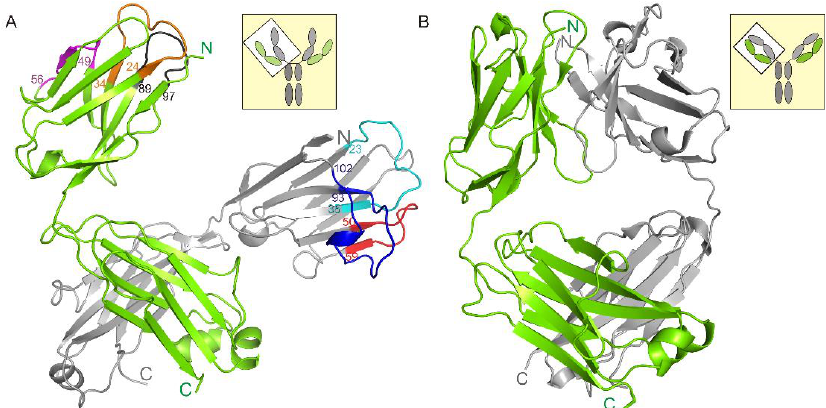
Figure 1. The structure of the netakimab Fab fragment. ( A ) The netakimab Fab fragment, light chain is colored green, heavy chain–gray. CDR-H1–cyan, CDR-H2–red, CDR-H3–blue. CDR-L1–brown, CDR-L2–violet, CDR-L3–black. Position numbers are shown for amino acid residues at the beginning and the end of CDRs. ( B ) The crystal structure of the human germline antibody IGHV5-51/IGKV3-20 (PDB entry 5I1K), light chain–green, heavy chain–gray.